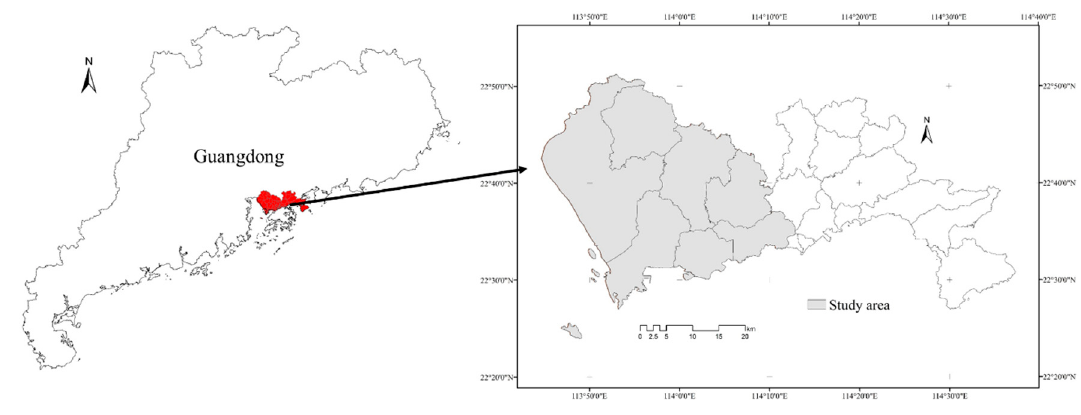
Figure 1. The location of the study area.